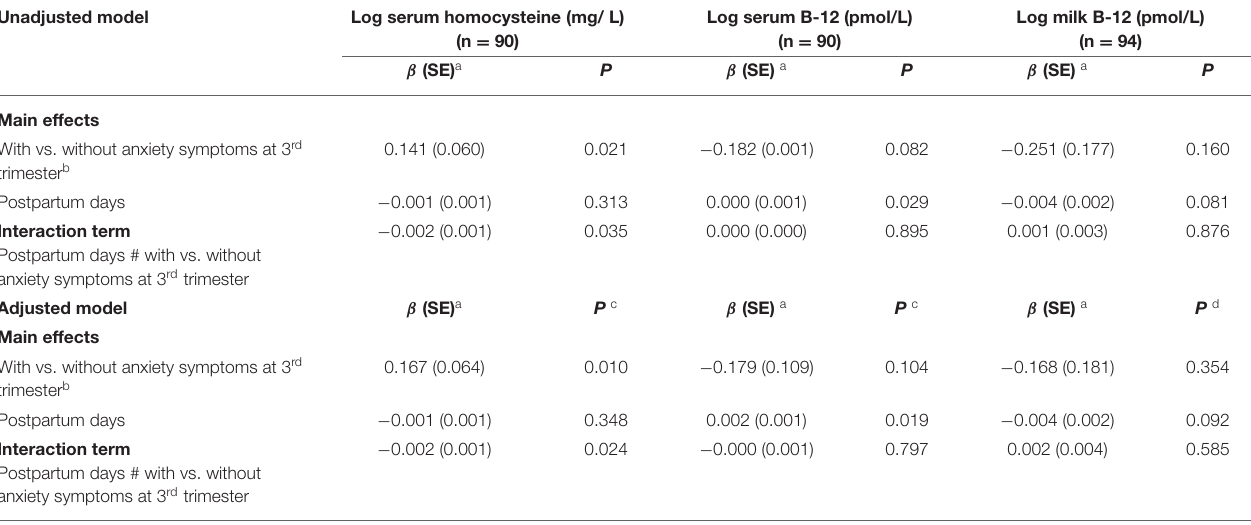
TABLE 3 | Models of longitudinal prediction of maternal serum homocysteine and vitamin B-12 and milk B-12 trajectories based on the presence of anxiety symptoms at the 3 rd trimester of pregnancy, Rio de Janeiro, Brazil. Unadjusted